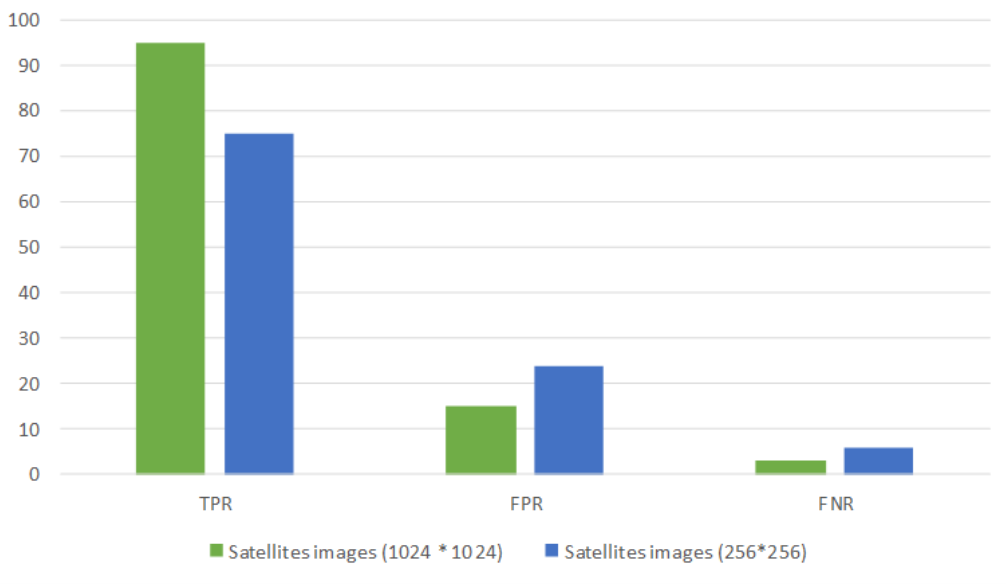
Figure 7: Statistical evolution of the results